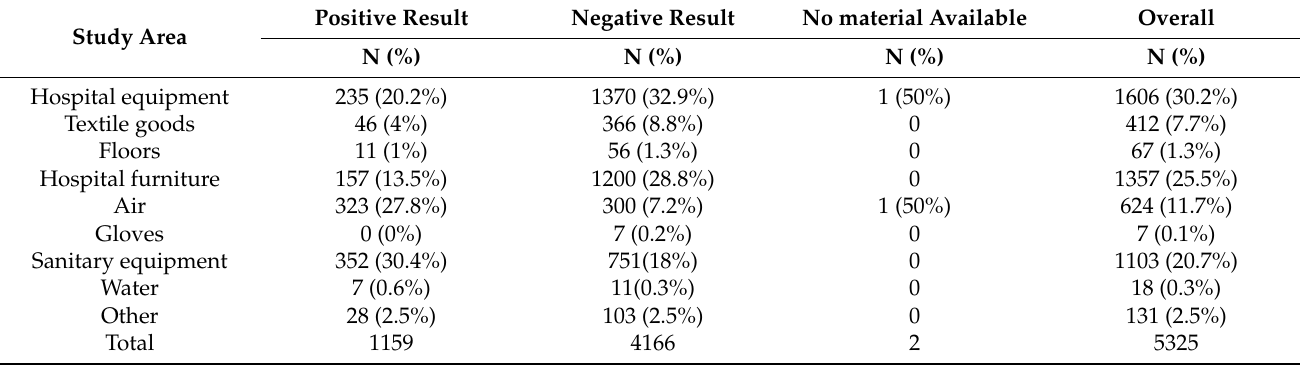
Table 1. Detailed distribution of the obtained results in the studied areas 1 .